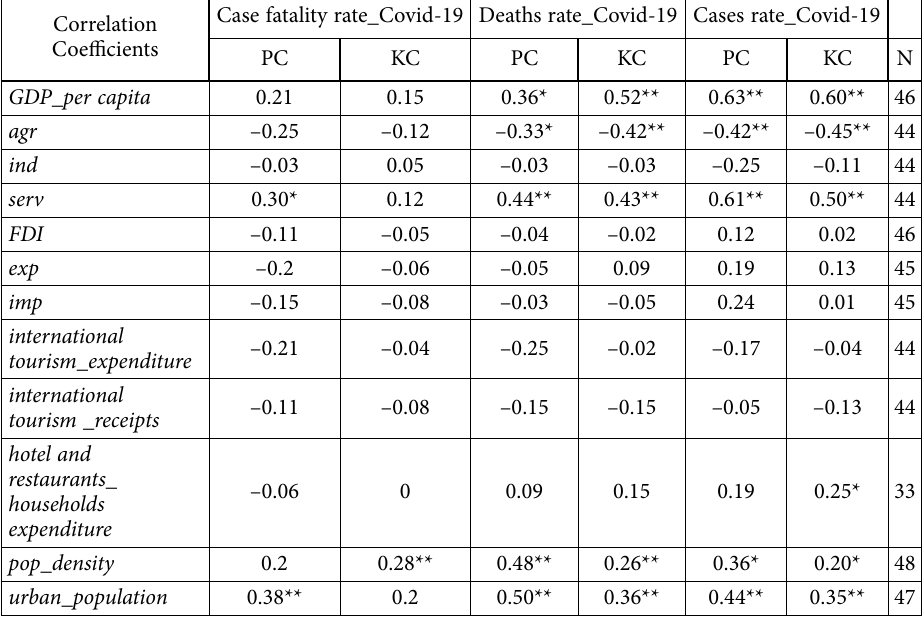
Table 2. Correlation analysis between development and connectivity indicators and Covid-19 indicators (source: authors’ computation using IBM SPSS Statistics 21) Correlation